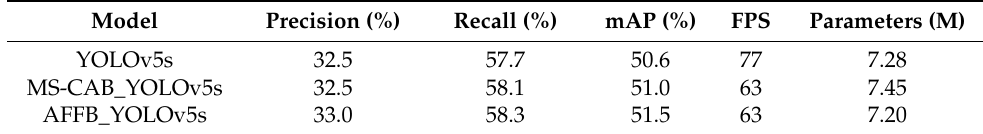
Table 2. Model performance comparison on the BDD100K validation